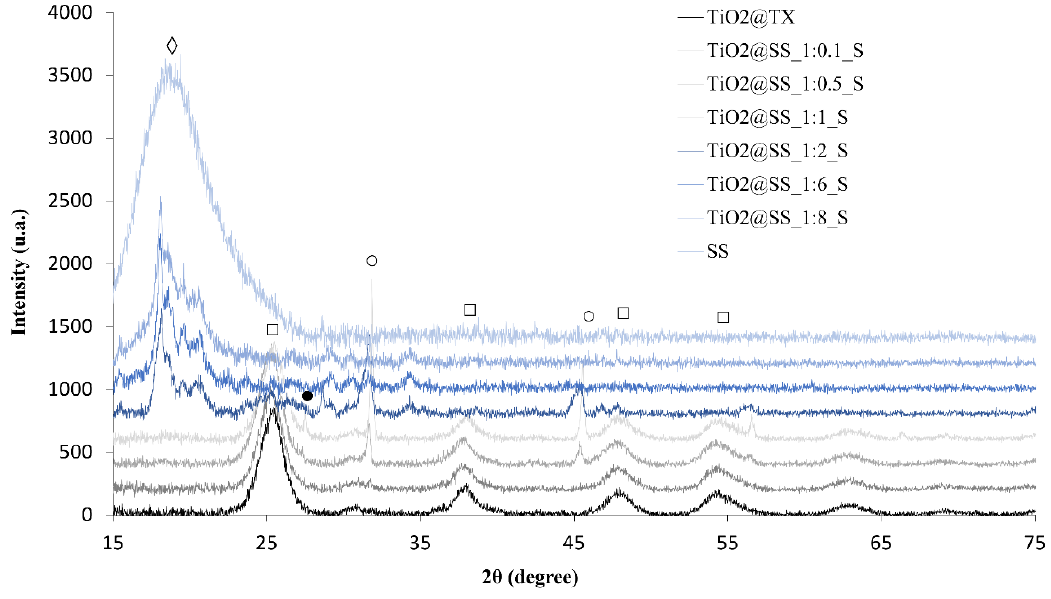
Figure 2. XRD diffractograms of TiO 2 @SS_S_SFD samples (◊ , sodium surfactin; □ , anatase; ● , brook- ite; ○ , sodium chloride).